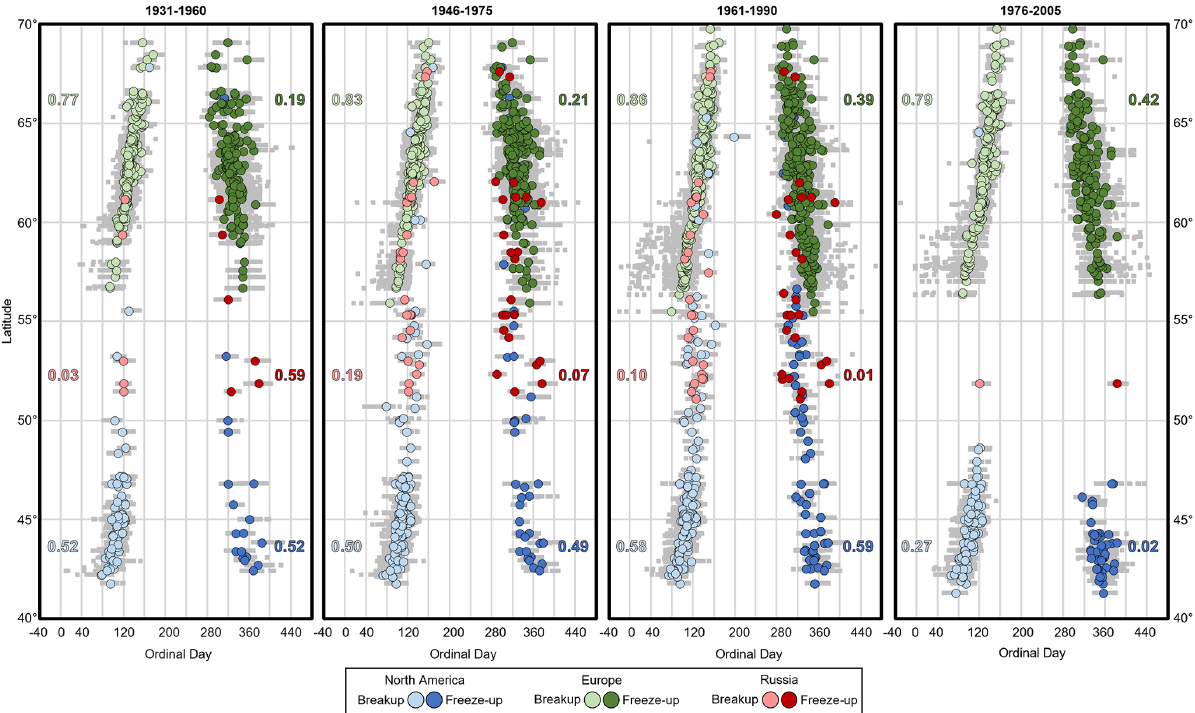
Figure 2. Summary graphs showing breakup and freeze-up dates against latitude for all lake and river sites included in each of the four 30-year-long time periods. The data are colour coded by region in the key. The numbers that are adjacent to the recorded dates are R 2 values for each set of regional data. These are also coloured coded on the key – e.g. light blue data show the median breakup dates for North America and an R 2 value between the median date and latitude of 0.52 from 1931–1960. The underlying grey points show the total ranges of dates that were recorded for each site in each time period. Note that some European breakup observations demonstrate that breakup occurred in the December preceding the start of that year’s open-water season – i.e. a very early winter cessation of the ice season. Likewise there are sites in all study areas where freeze-up dates were sufficiently late that they did not occur until late in the winter season – i.e. January or February of the following